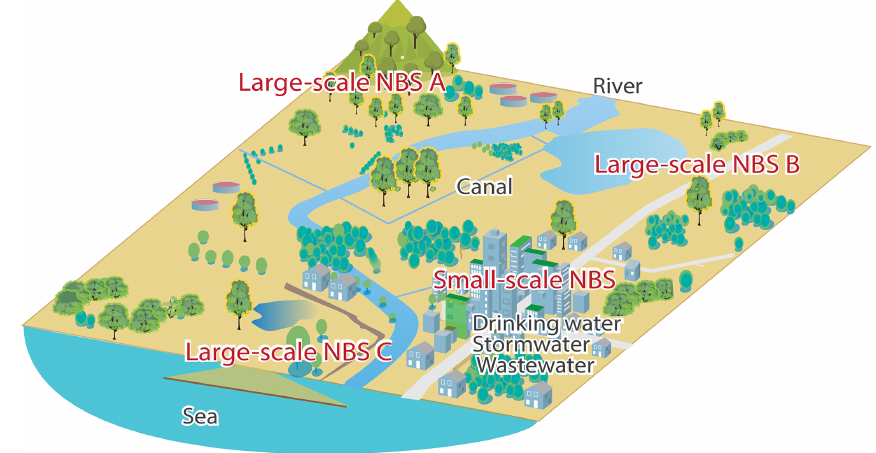
Figure 3. Illustration of large and small-scale nature-based solutions (NBSs). Large-scale NBS A illustrates NBSs in mountainous regions (e.g. afforestation, slope stabilisation, etc.), large-scale NBS B illustrates NBSs along river corridors (e.g. widening river, retention basins, etc.) and large-scale NBS C illustrates NBSs in coastal regions (e.g. sand dunes, protection dikes and walls, etc.). Typical examples